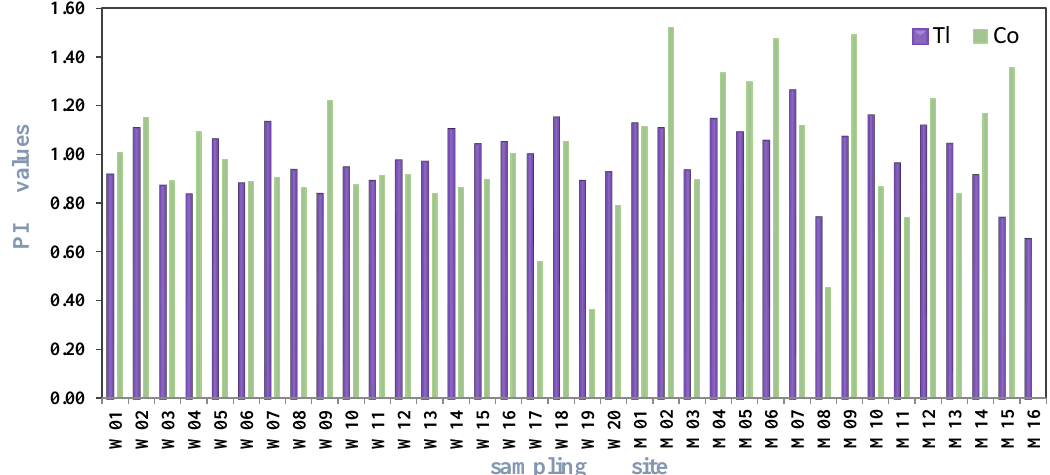
Figure 5. Single pollution indices ( PI ) based on geochemical baseline concentrations (GBCs) for each sampling site.